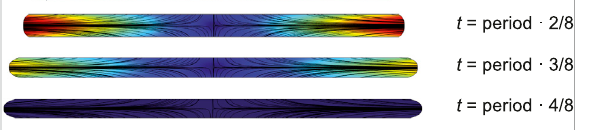
FIGURE 2 Dynamic evolution of SD geometry at 0, 1 contraction period. The black contours represent velocity fi elds of cytosol.Thecolorcodeshowsthemagnitudeofvelocityfromdark blue, equals to 0, to dark red as maximum value.